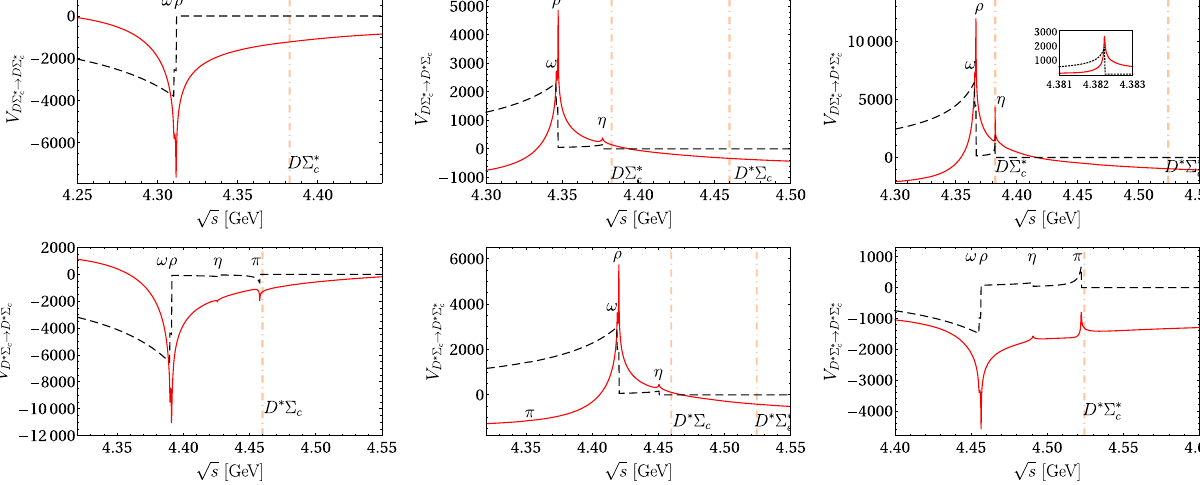
Fig. 3 V matrix for the S -wave D (cid:2) ∗ c - D ∗ (cid:2) c - D ∗ (cid:2) ∗ c coupled-channel system with ( I , J ) = ( 1 / 2 , 3 / 2 ) (real part: solid curve, imaginary part: dashed curve). The corresponding threshold is represented by the orange dash-dotted